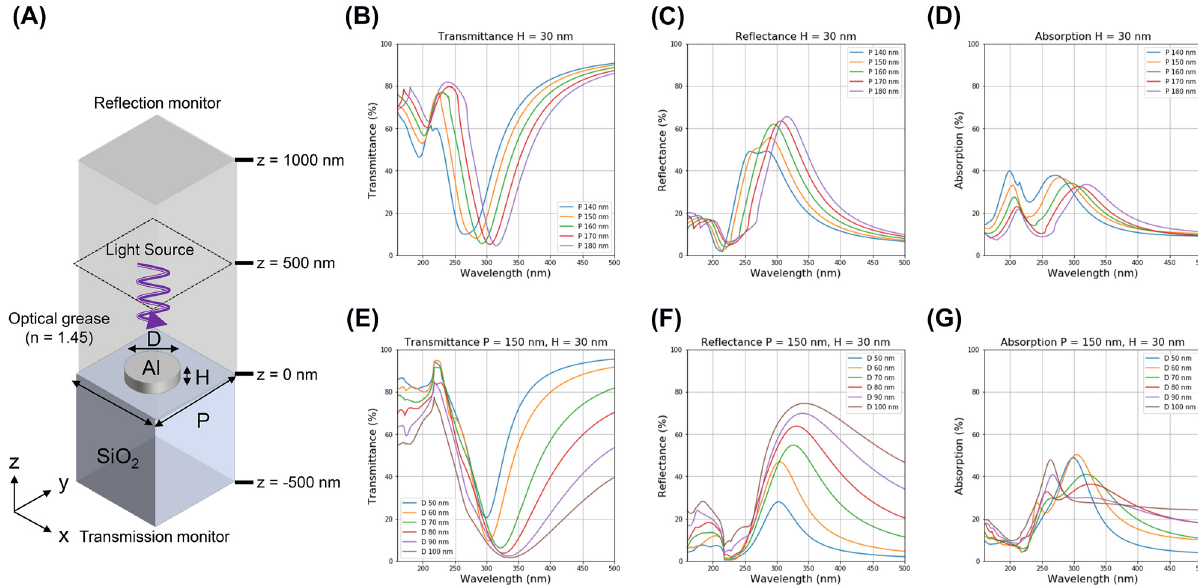
Figure 6: Schematic of FDTD simulation model and simulation results. (A) Schematic of the FDTD simulation for the aluminum nanodisk (B)–(D) FDTD simulation results of the transmittance, reflectance, and absorption spectra of the aluminum nanodisk for periods from 140 to 180 nm (in 10 nm intervals), respectively. (E) and (G) FDTD simulation results of the transmittance, reflectance, and absorption spectra of the aluminum nanodisk for diameters from 50 to 100 nm (in 10 nm steps), respectively.